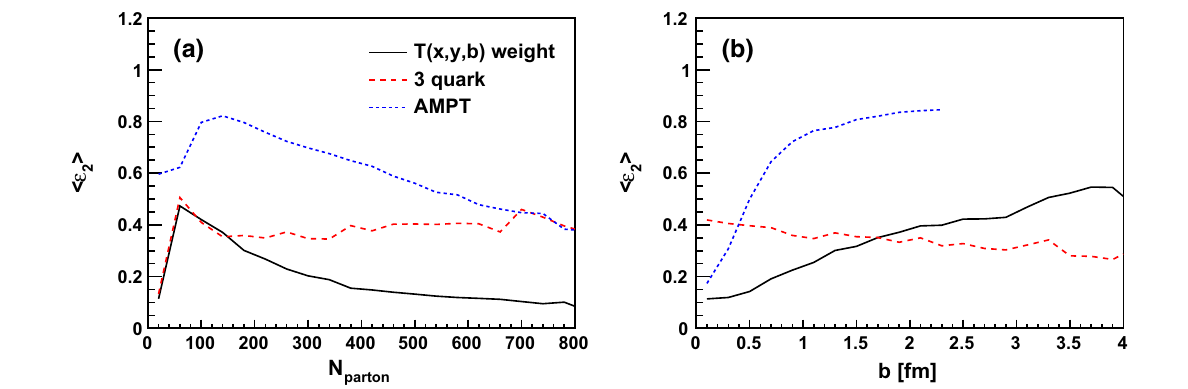
dashed line) from our approach in contrast to those from the full AMPT model (blue dotted line) using parton positions right after string melting